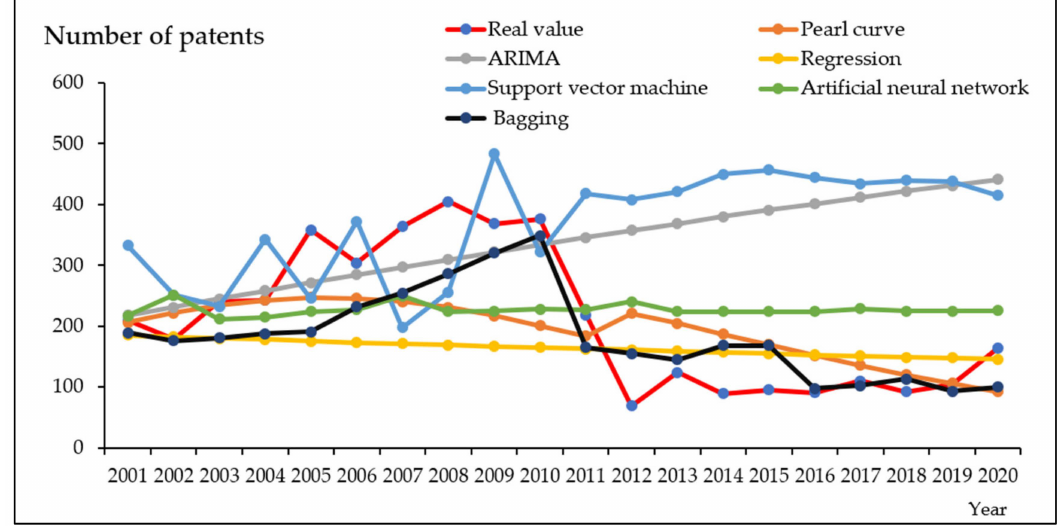
Figure 4. The trend of the actual patent number and various prediction methods.